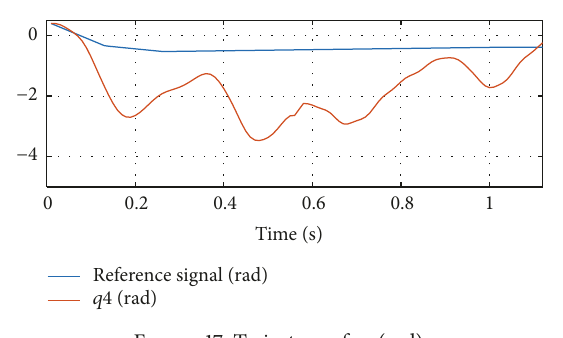
Figure 17: Trajectory of 𝑞 4 (rad).